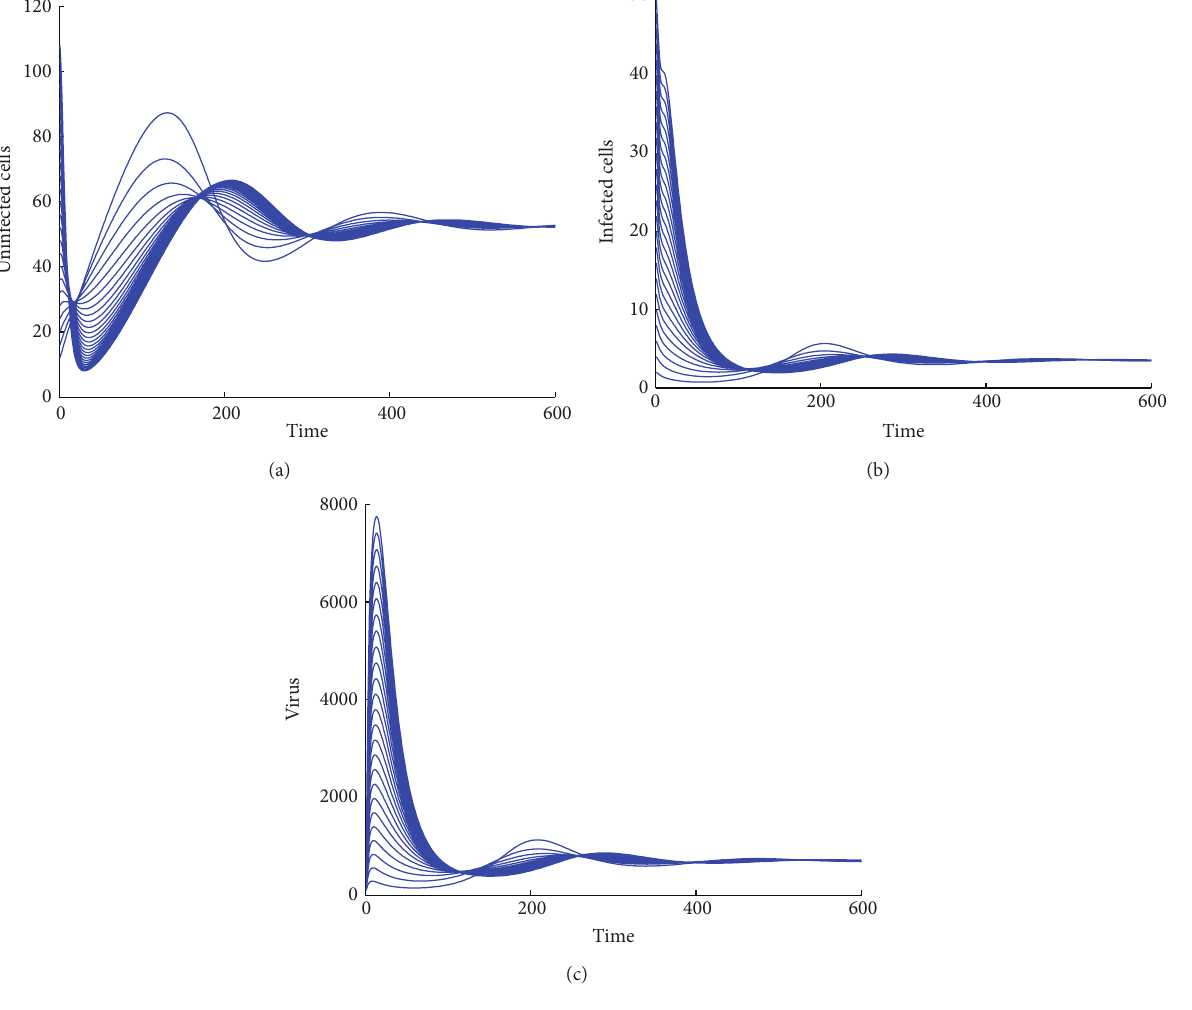
Figure 2: Demonstration of the stability of 𝐸 ∗